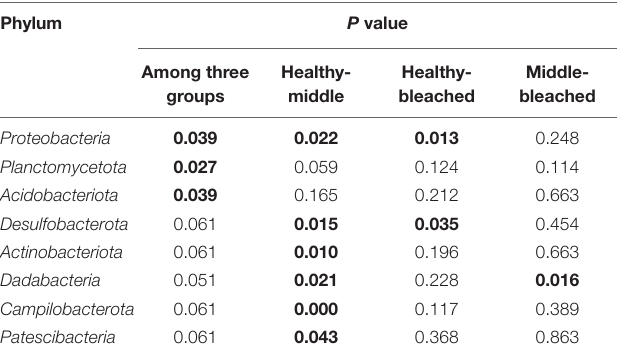
TABLE 1 | Statistical analysis of dominant bacterial phyla in bacterial communities associated with P. onkodes . Phylum P value